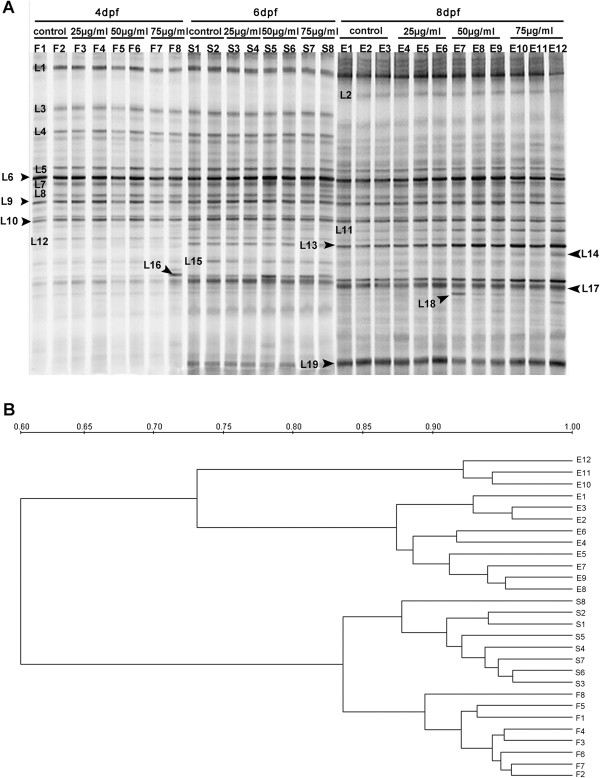
Intestinal microbiota dysbiosis in zebrafish with TNBS-induced enterocolitis. A: Representative denaturing gradient gel electrophoresis (DGGE) profiles generated for the gut microbiota community of zebrafish with TNBS-exposure and without it (control) collected at 4, 6 and 8 dpf. B: Dendrogram constructed with intestinal microbiota community fingerprints based on cluster analysis by unweighted pair group method using arithmetic averages (UPGMA).